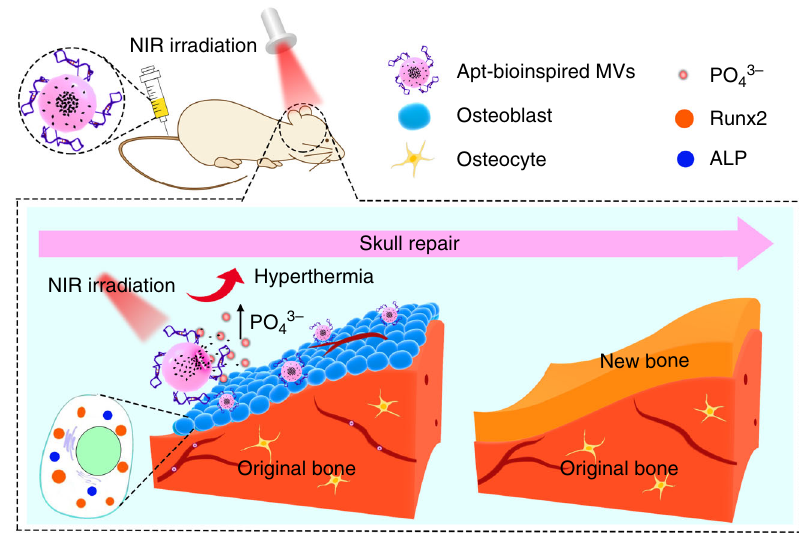
Fig. 1 Overview of Apt-bioinspired MVs in cell mineralization. ALP, alkaline phosphatase; Runx2, runt-related transcription factor